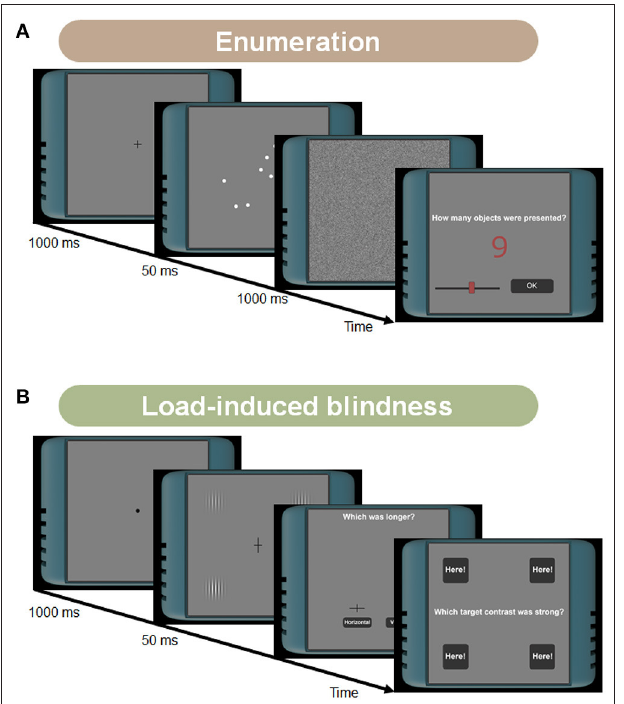
FIGURE 3 | (A) Stimuli and tasks in the go/no-go task. On each trial, a digit was briefly presented one by one. Participants were asked to focus on the number “7” and answer whether the number after the “7” was the “3” or not. If the number after “7” was “3,” they had to press the key “J” as soon as possible. (B) Stimuli and tasks in the task-switching task. Participants’ tasks changed with the task cue. When the task cue was the blue diamond-shaped background, participants had to answer whether the target digit was odd/even. In contrast, when the task cue was the red square background, they had to answer whether the target digit was higher/lower than